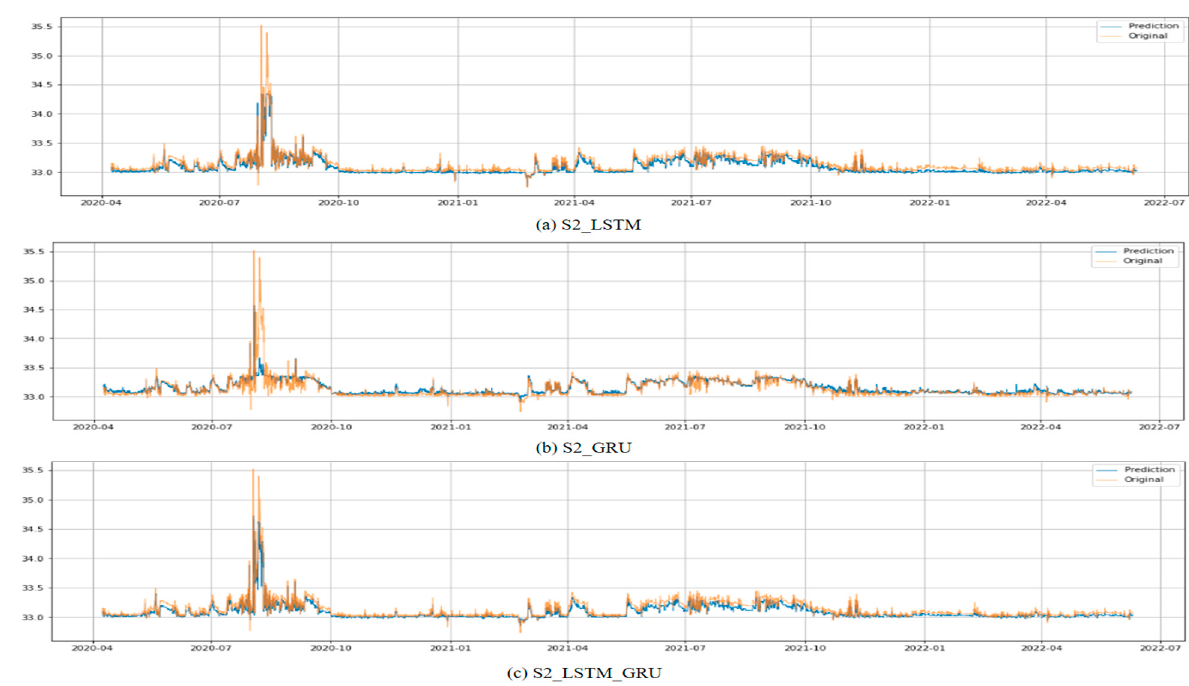
Figure 15. Comparison graph of observed and predicted values for each model in S1 case. ( a ) Multi- LSTM; ( b ) multi-GRU; and ( c ) LSTM–GRU.